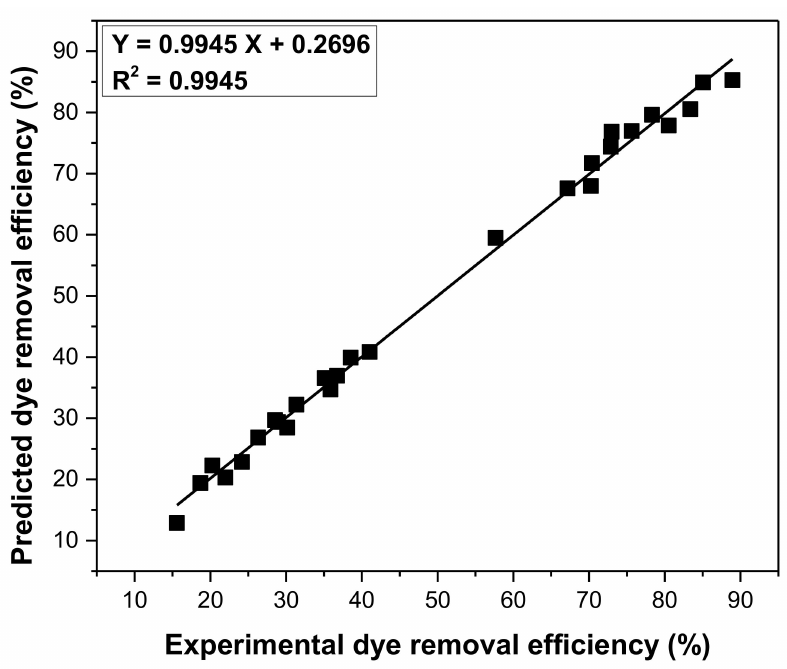
Figure 6. Comparison of experimental and predicted dye removal